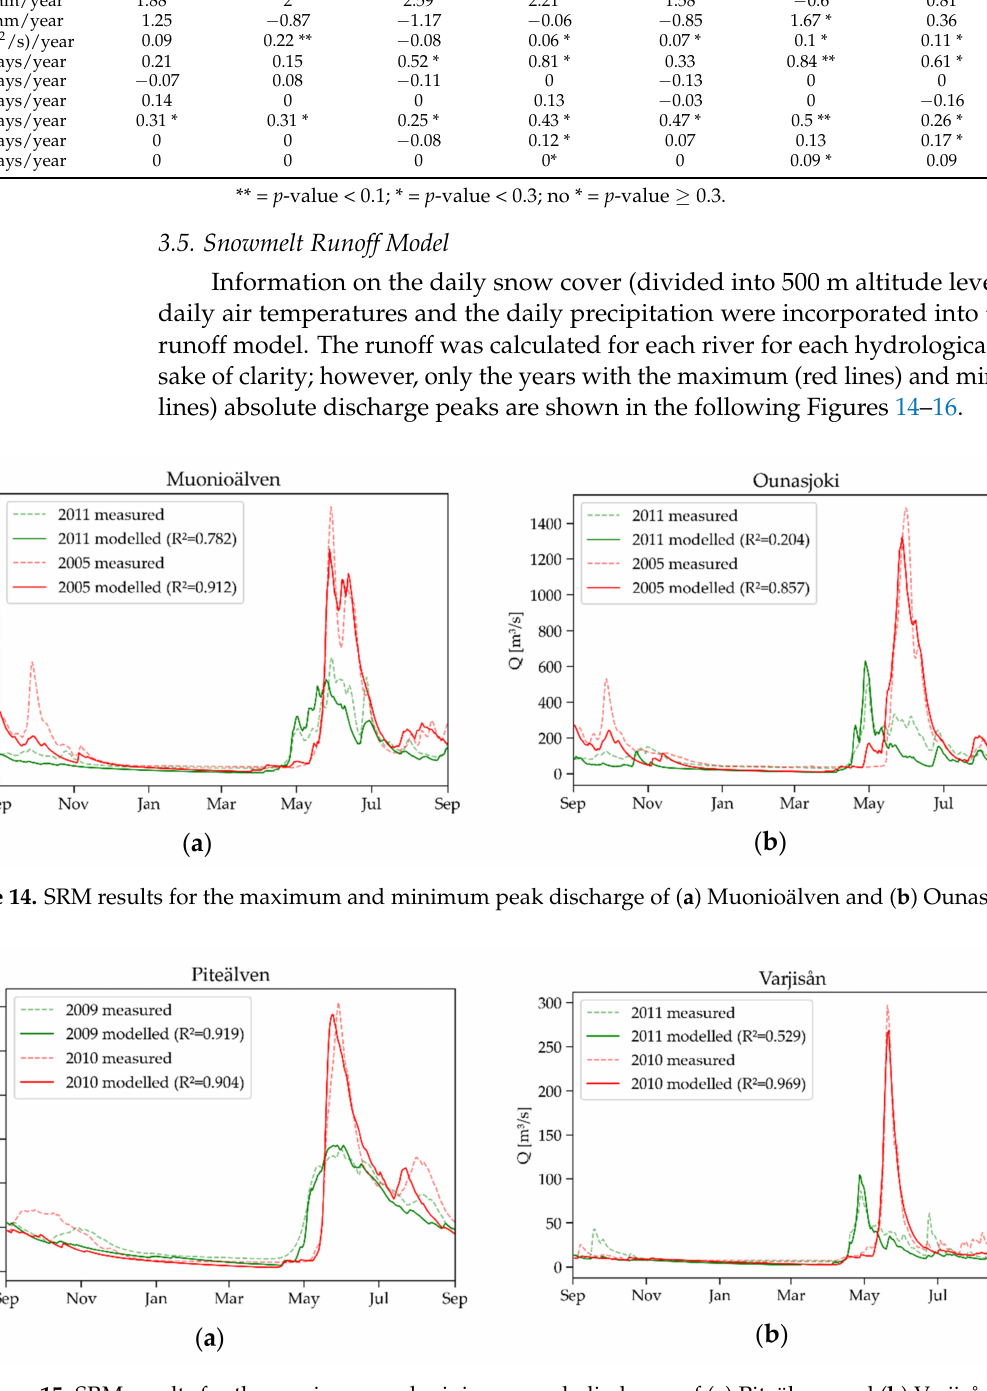
Figure 15. SRM results for the maximum and minimum peak discharge of ( a ) Piteälven and ( b )